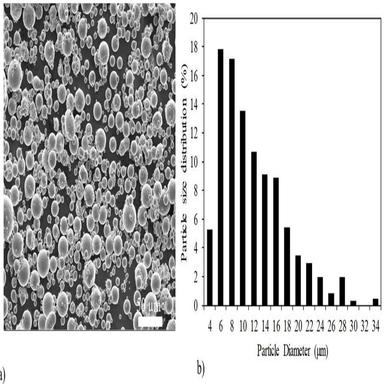
AlSi10Mg powder used in the fabrication of the samples. a) SEM image showing the shape and size of the powder. b) Particle size distribution.